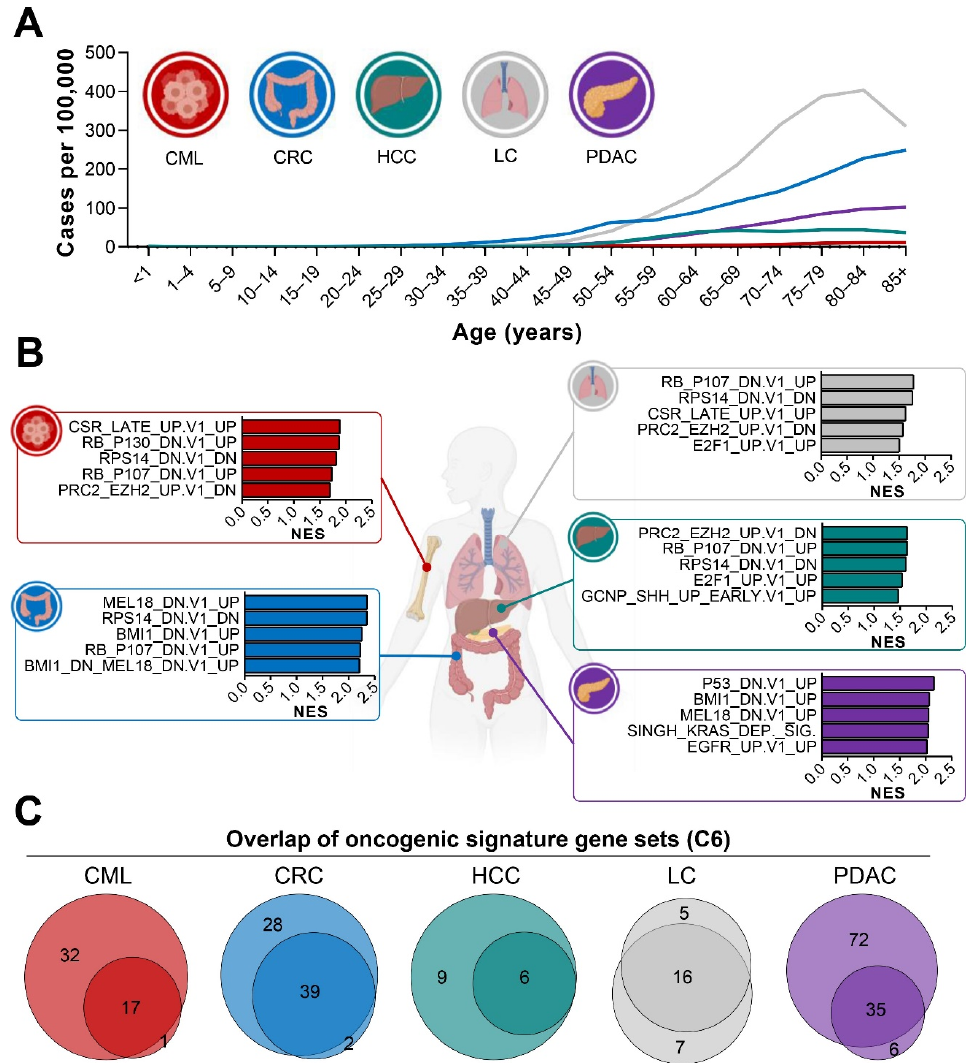
Figure 1. Cancer incidence increases with age and mRNA-seq analyses reveal molecular pathways underlying this group of diseases. ( A ) Cancer cases per 100,000 were obtained from publicly available sources [60] and depicted for different age groups in CML, CRC, HCC, LC, and PDAC. While global incidence was highly heterogeneous among cancer entities, all diseases were more abundant in the elderly compared to the young population. ( B ) To examine transcriptome-wide changes, GSEA for oncogenic signatures (Collection 6: oncogenic signature gene set, [C6]) was performed using publicly available CML, CRC, HCC, LC, and PDAC mRNA-seq datasets [34,36,38,41,45]. Five pathways with the highest enrichment were exemplarily shown for one dataset per cancer entity. Raw data is provided in Table S2. ( C ) A comparison of enriched GSEA oncogenic signatures (C6) revealed high similarities between the two datasets analyzed per cancer type. Raw data is provided in Table S2. Parts of panel A and B were created with BioRender.com (accessed on 14 September 2021). NES: normalized enrichment score, CML: chronic myelogenous leukemia, CRC: colorectal cancer, HCC: hepatocellular carcinoma, LC: lung cancer, PDAC: pancreatic ductal